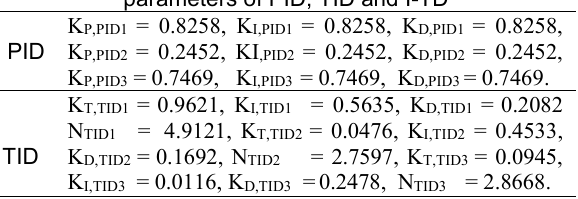
Table 1. (a) GHA optimized controller gains